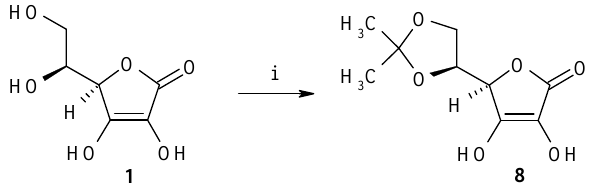
Scheme 5 : Protection of the C-5 and C-6 positions of L-ascorbic acid.